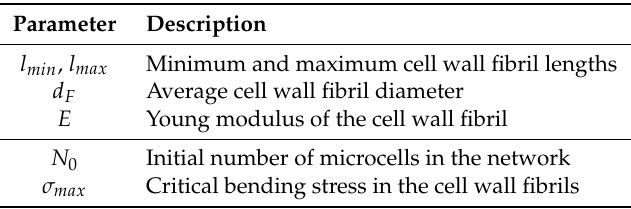
Table 2. Description of material parameters in the presented